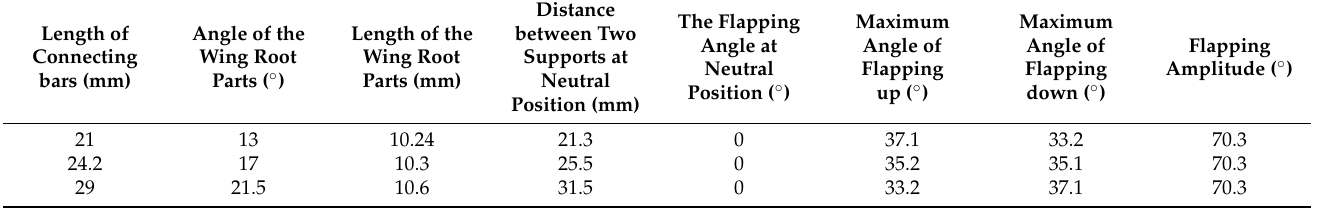
Figure 19. The maximum angle of flapping up and down. Table 4. The parameters of FWR with different maximum angles of flapping up and down.